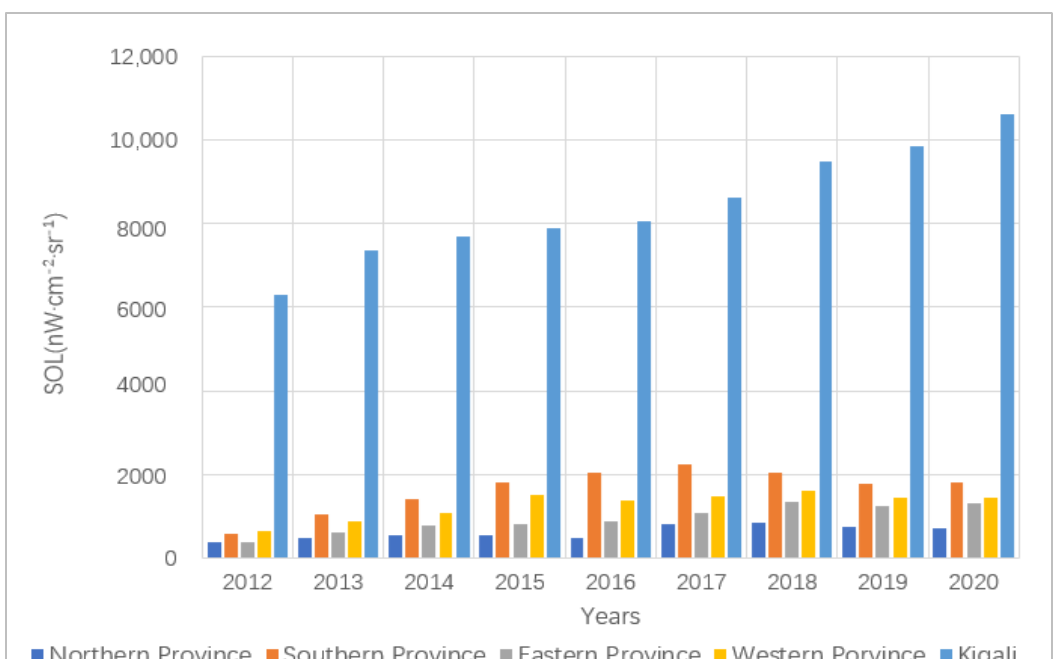
Figure 7. SOL of each province in Rwanda from 2012 to 2020.